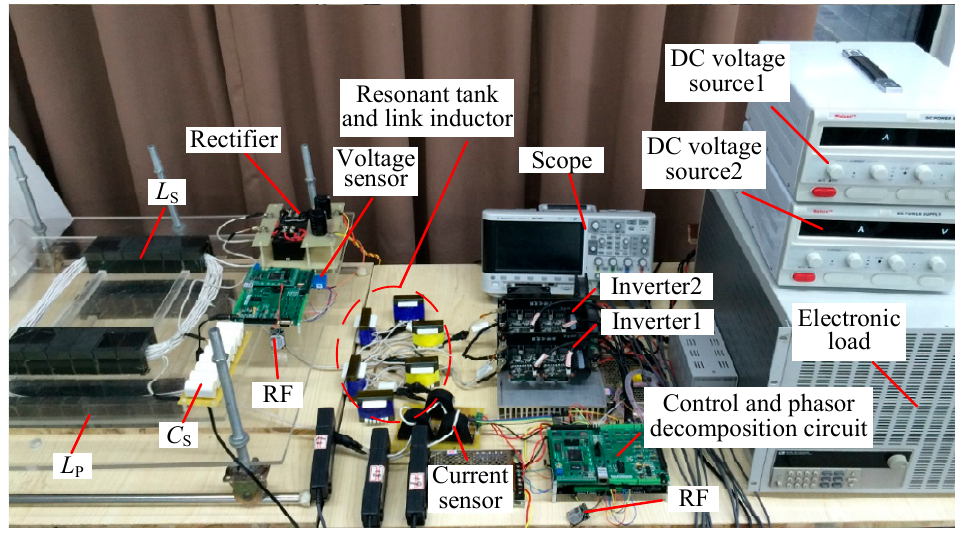
Figure 9. The exterior appearance of the proposed IPT prototype.